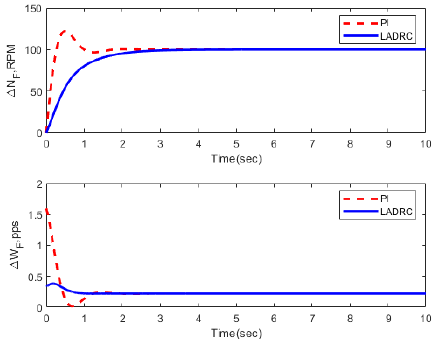
Figure 23. Step response of FC14.